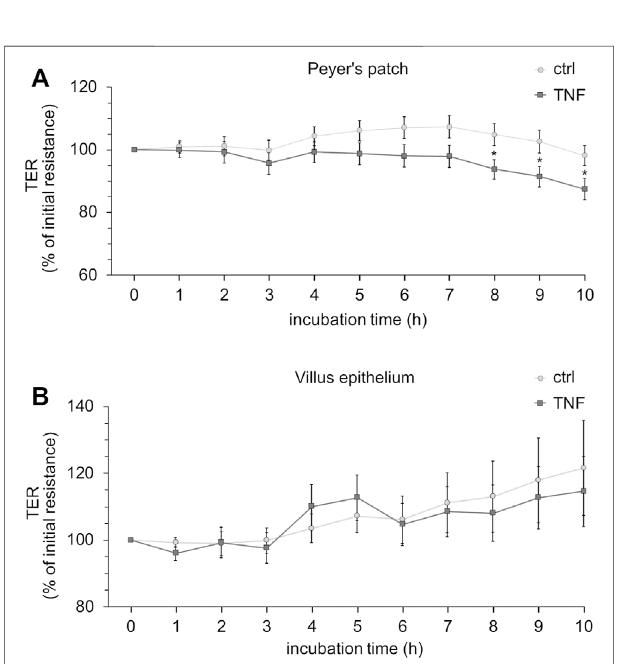
FIGURE2|(A) Representativeimagesofhematoxylin-eosin-stainedtissues (B) AnalysisofvilluslengthofPeyer ’ spatch(PP)-surroundingvillusepithelium(VE)after 10 h in the Ussing chamber with or without TNF (scale bar: 0.1 mm, n = 6).